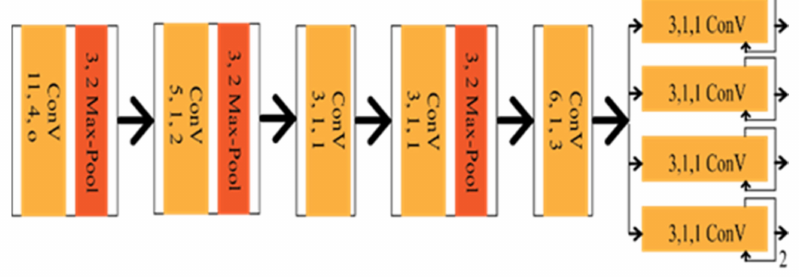
Figure 3. Schematic diagram of